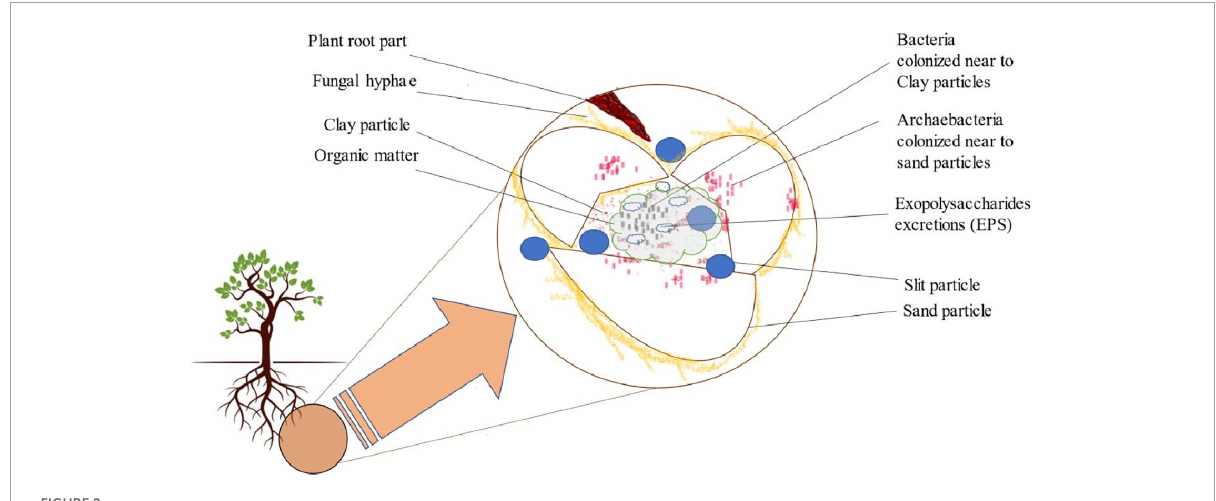
FIGURE2 Diagrammatic presentation of phytomicrobiomes in soil